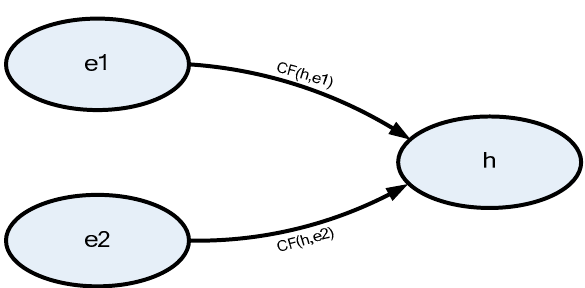
Figure 2. Parallel transitions between two observations and a hypothesis.